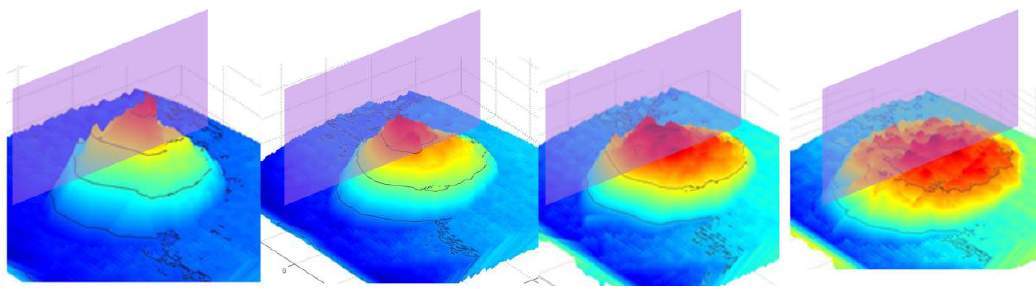
Figure 10. Spreading shape of concrete slump flow with time.